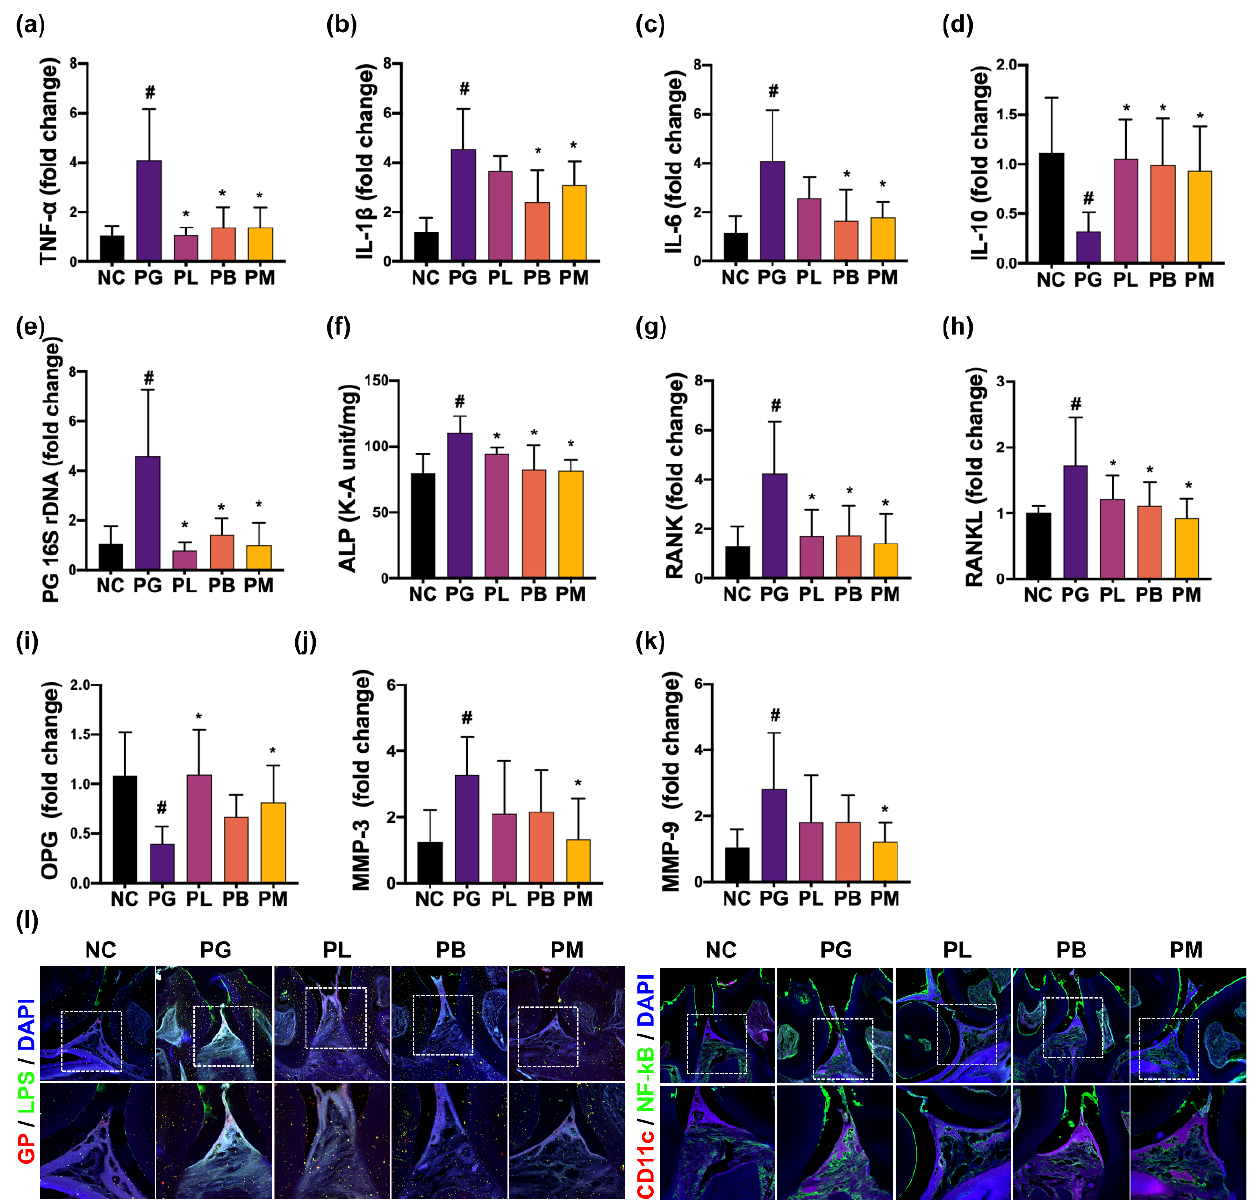
Figure 2. NK357, NK391, and NKc alleviated PG-induced periodontitis in mice. Effects on the expression of TNF- α ( a ), IL-1 β ( b ), IL-6 ( c ), and IL-10 ( d ) and PG 16S rDNA level ( e ) in the periodontal tissue. Effects on the expression of alkaline phosphatase activity ( f ) and RANK ( g ), RANKL ( h ), OPG ( i ), MMP-3 ( j ), and MMP-9 expression ( k ) and GP + LPS + and NF- κ B + CD11c + cell populations ( l ) in the periodontal tissue. Data were described as mean ± SD ( n = 6). # p < 0.05 vs. NC. * p < 0.05 vs. PG.